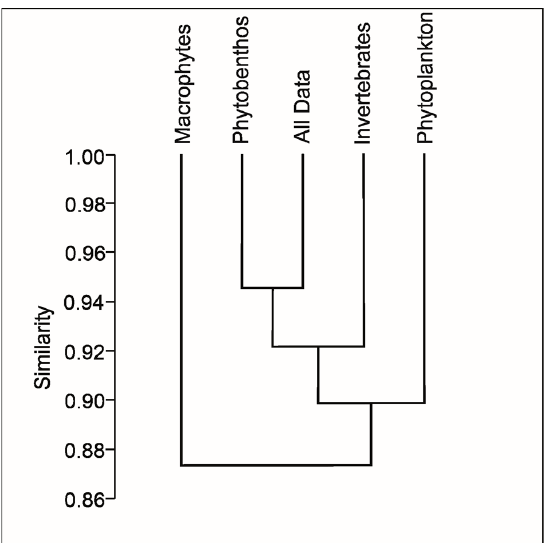
Figure 11. The similarity of the ecological state assessment results of the Siversky Donets river basin based on different biological quality elements (phytoplankton, macrophytes, phytobenthos, bottom invertebrates and integral assessment on the basis of all